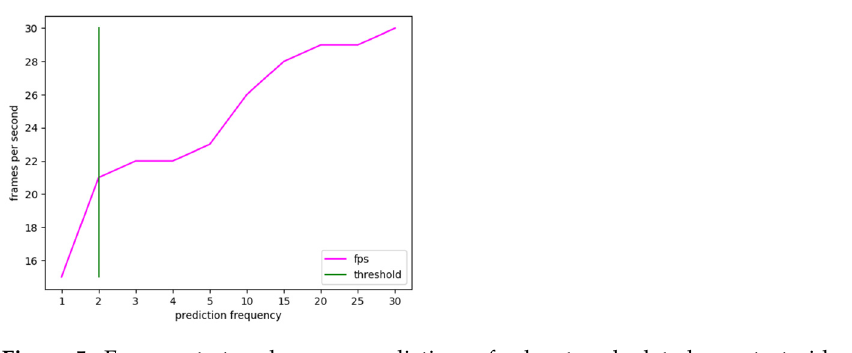
Figure 5. Frame rate trend versus prediction refresh rate calculated on a test video stream. The value 2 was experimentally chosen as the optimal tradeoff between real-time and accuracy.